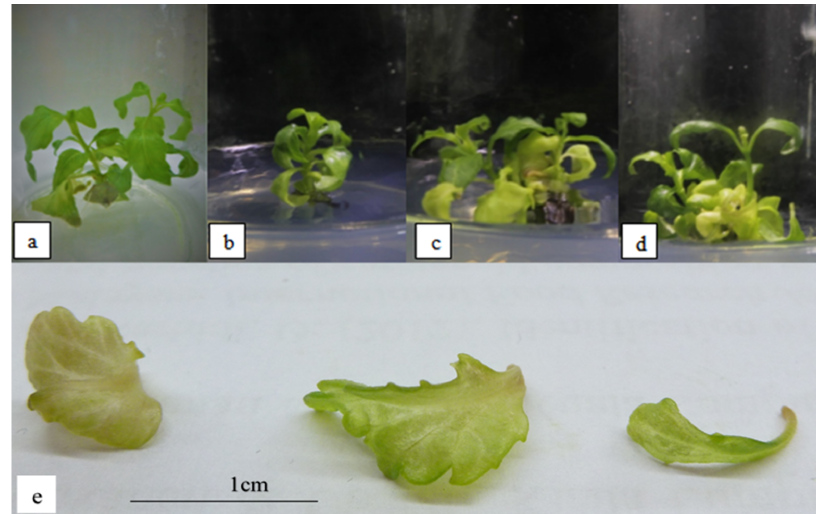
Figure 2. O . stamineus subjected to ABA stress harvested after the third subcultures: ( a ) 1 μ M ABA; ( b ) 2 μ M ABA; ( c ) 4 μ M ABA; ( d ) 6 μ M ABA; ( e ) hyperhydricity observed in leaves subjected to ABA stress.